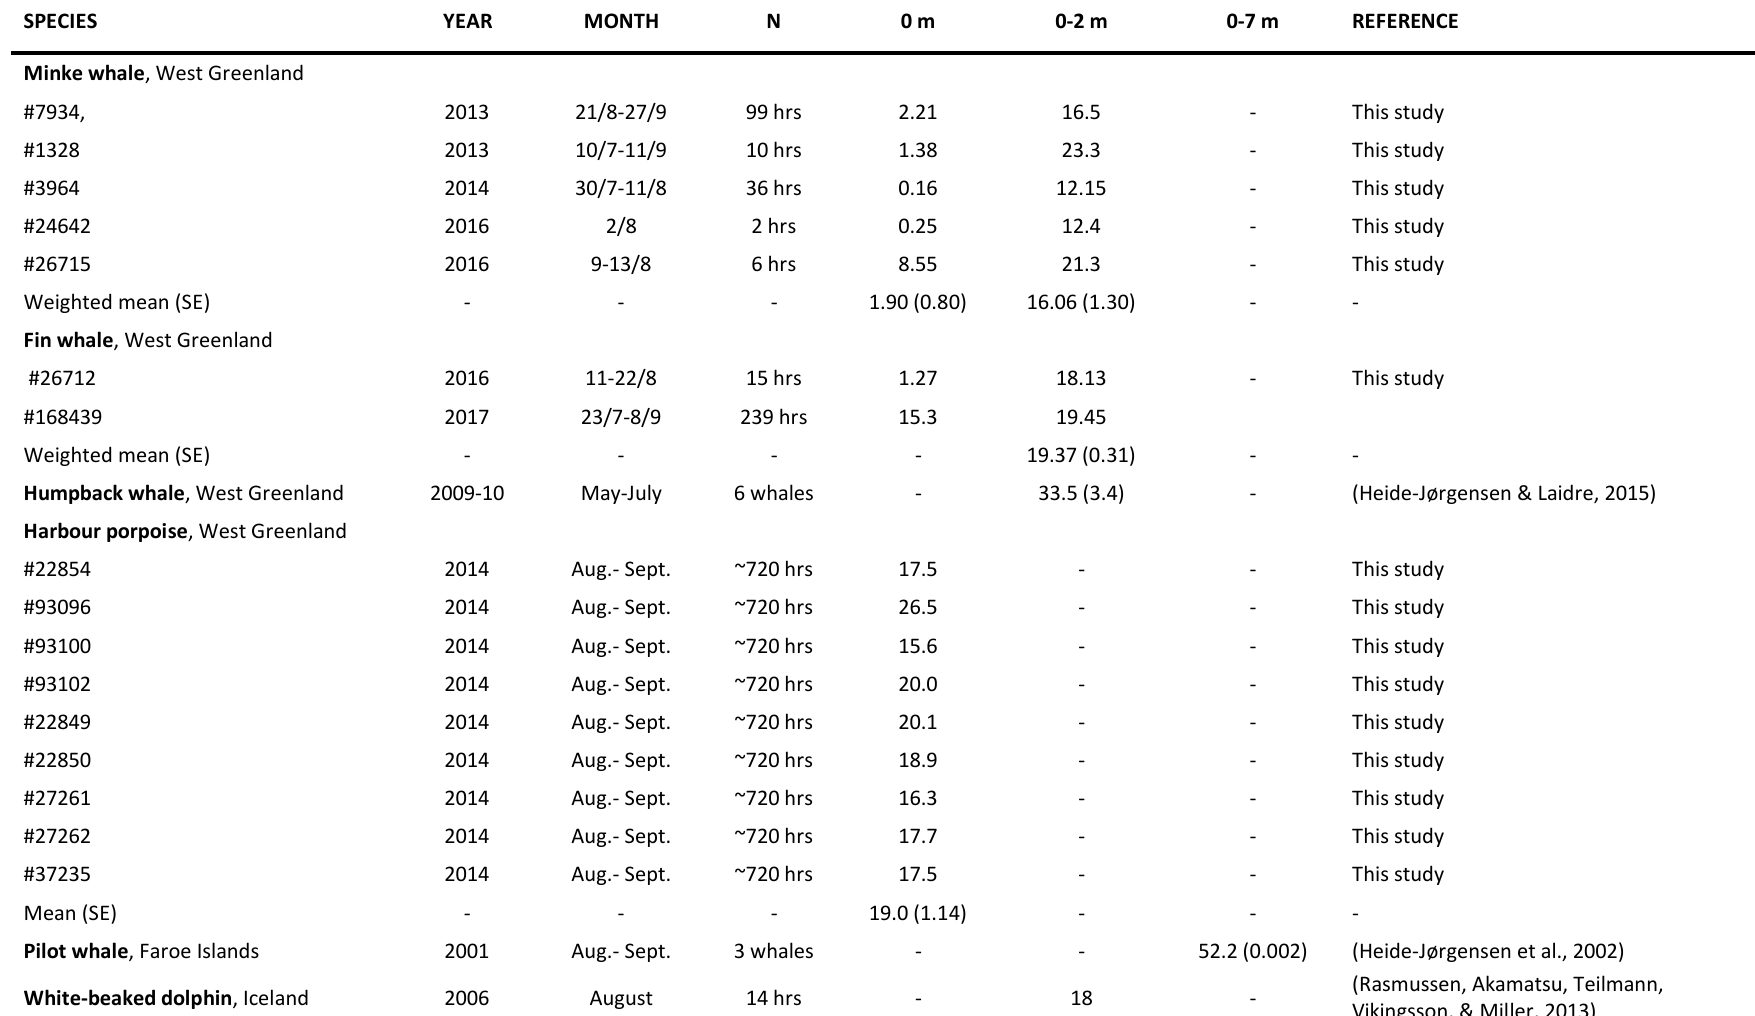
Table 1. Overview of data used for correction of the surface availability of the whales. Only data collected during daylight (07:00-19:00 GMT) and before 27 September are included. Data were extracted from messages relayed by satellite-linked time-depth-recorders.